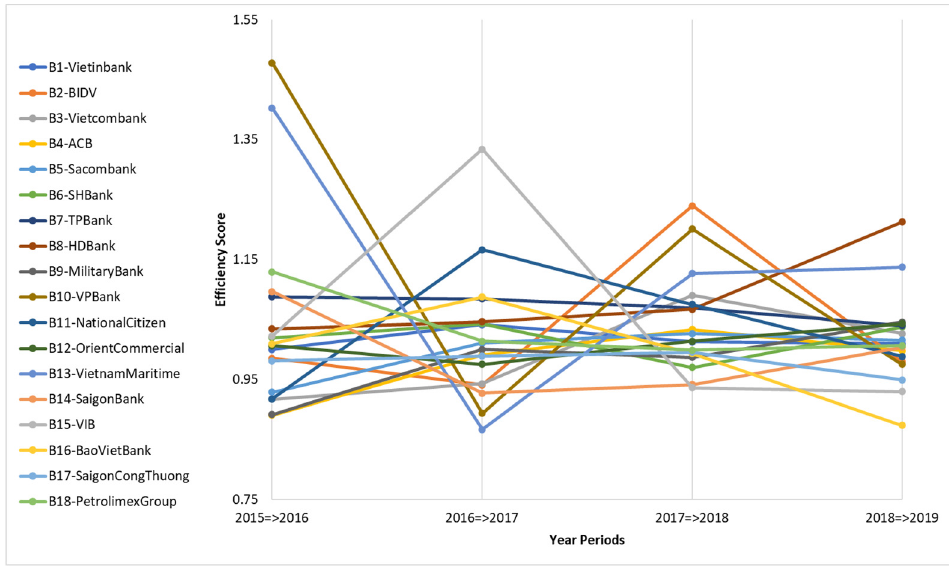
Figure 4. Malmquist productivity indexes of the DMUs (2015–2019).